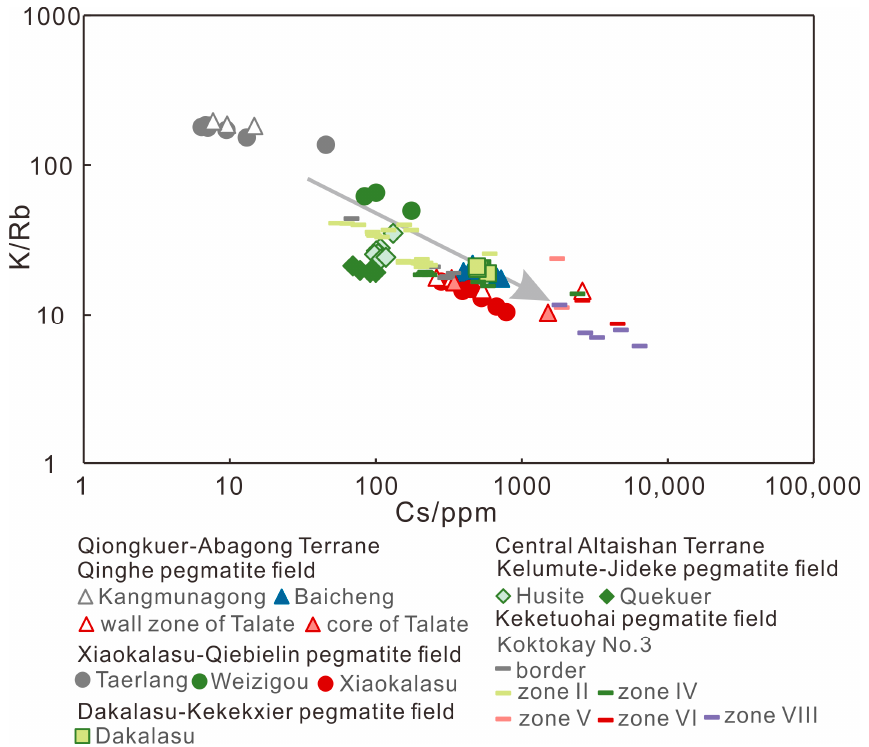
Figure 6. Plot of K/Rb vs. Cs content for muscovites from the pegmatites studied and the Koktokay No.3 pegmatite in the Chinese Altai. The regions of zones I–IV and zones V–VIII of the Koktokay No.3 pegmatite are based on the data from